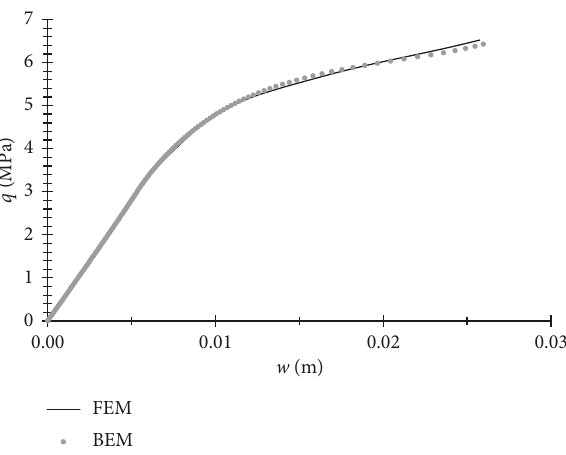
Figure 2: Verification between FEM and BEM for a square plate.